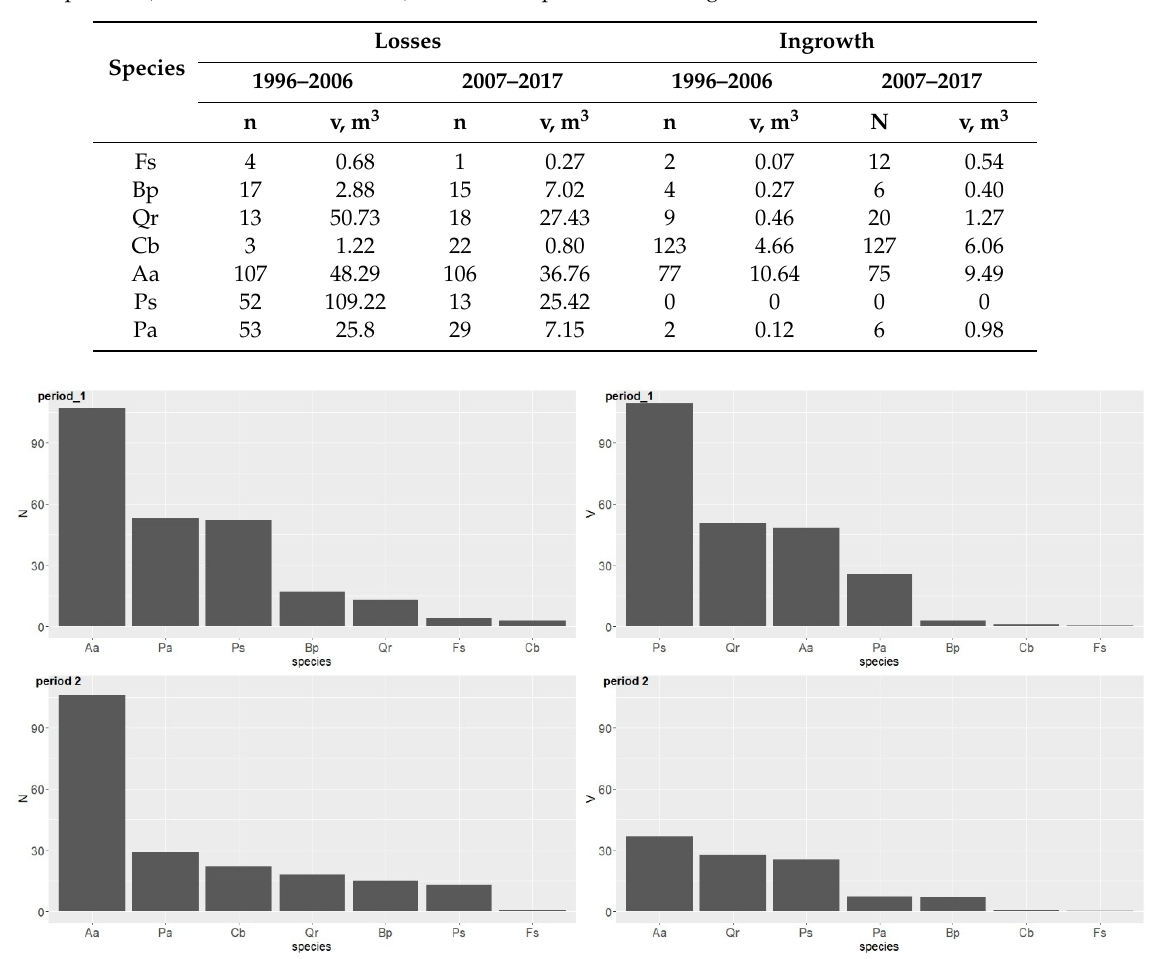
Figure 6. Number (nha − 1 ) and volume (m 3 ha − 1 ) of losses by tree species over two periods in the uneven-aged forest located in the Unieszów Forestry Range.